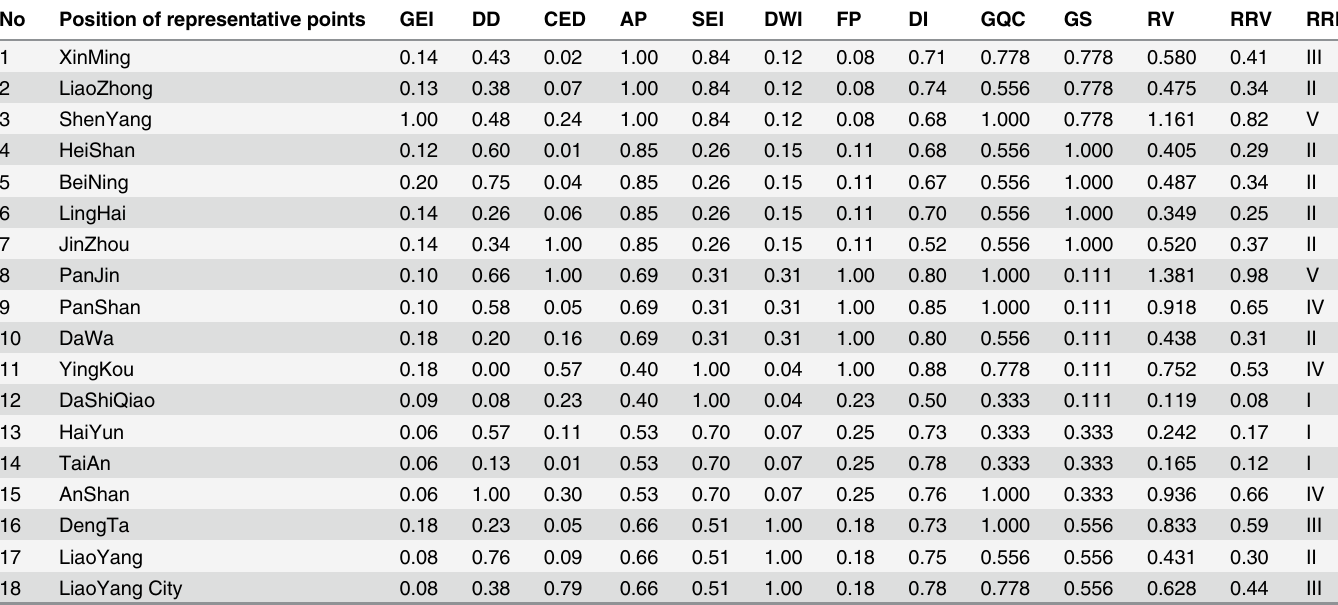
Table 6. The relative risk value calculations for representative points.